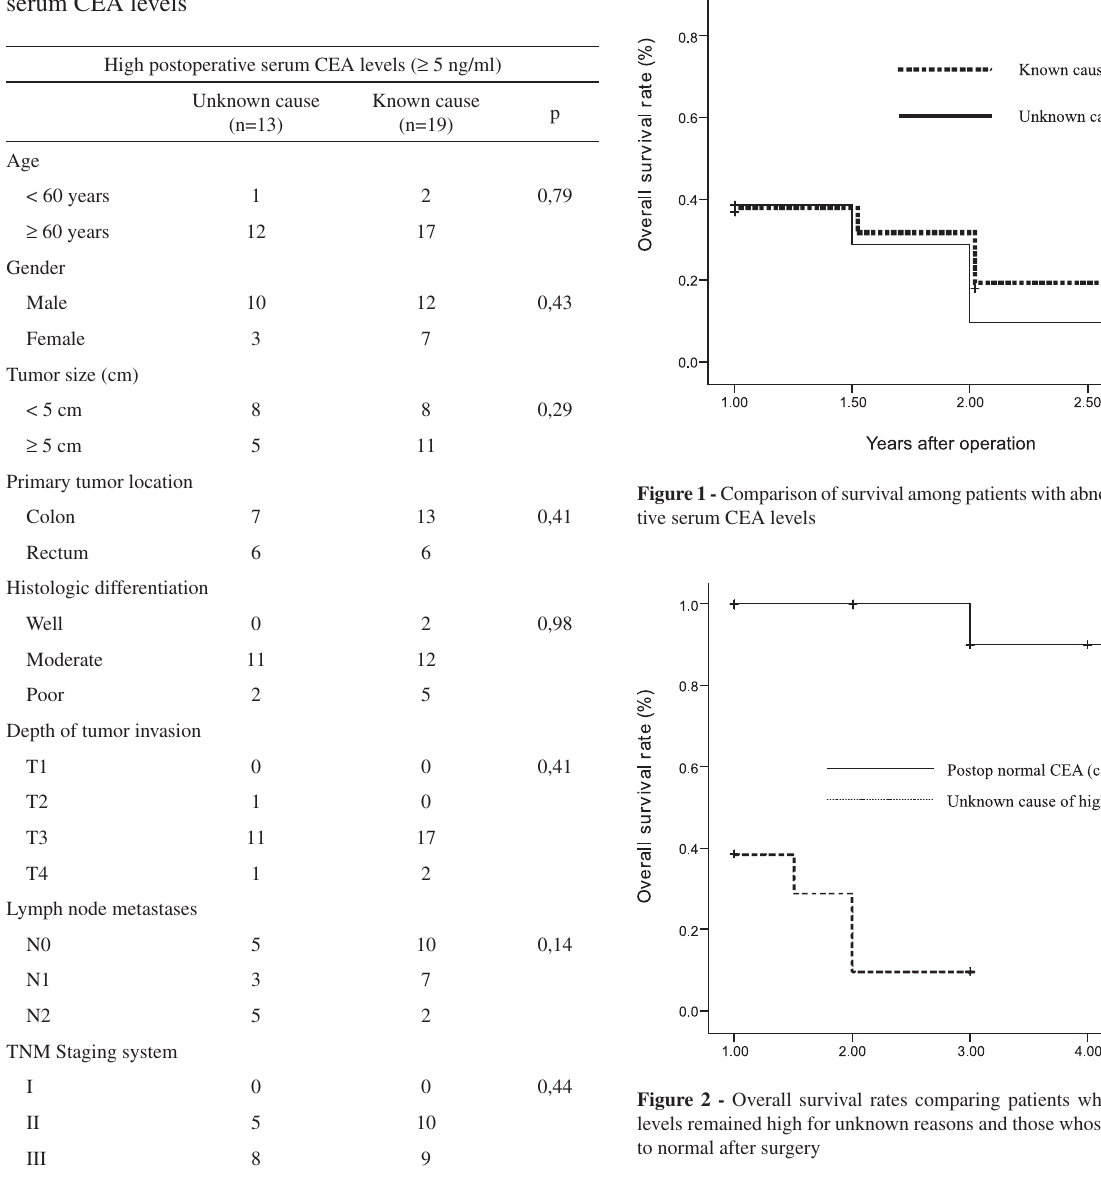
Table 3 - Demographic and clinical features and their cause- related association in patients with abnormal postoperative serum CEA levels